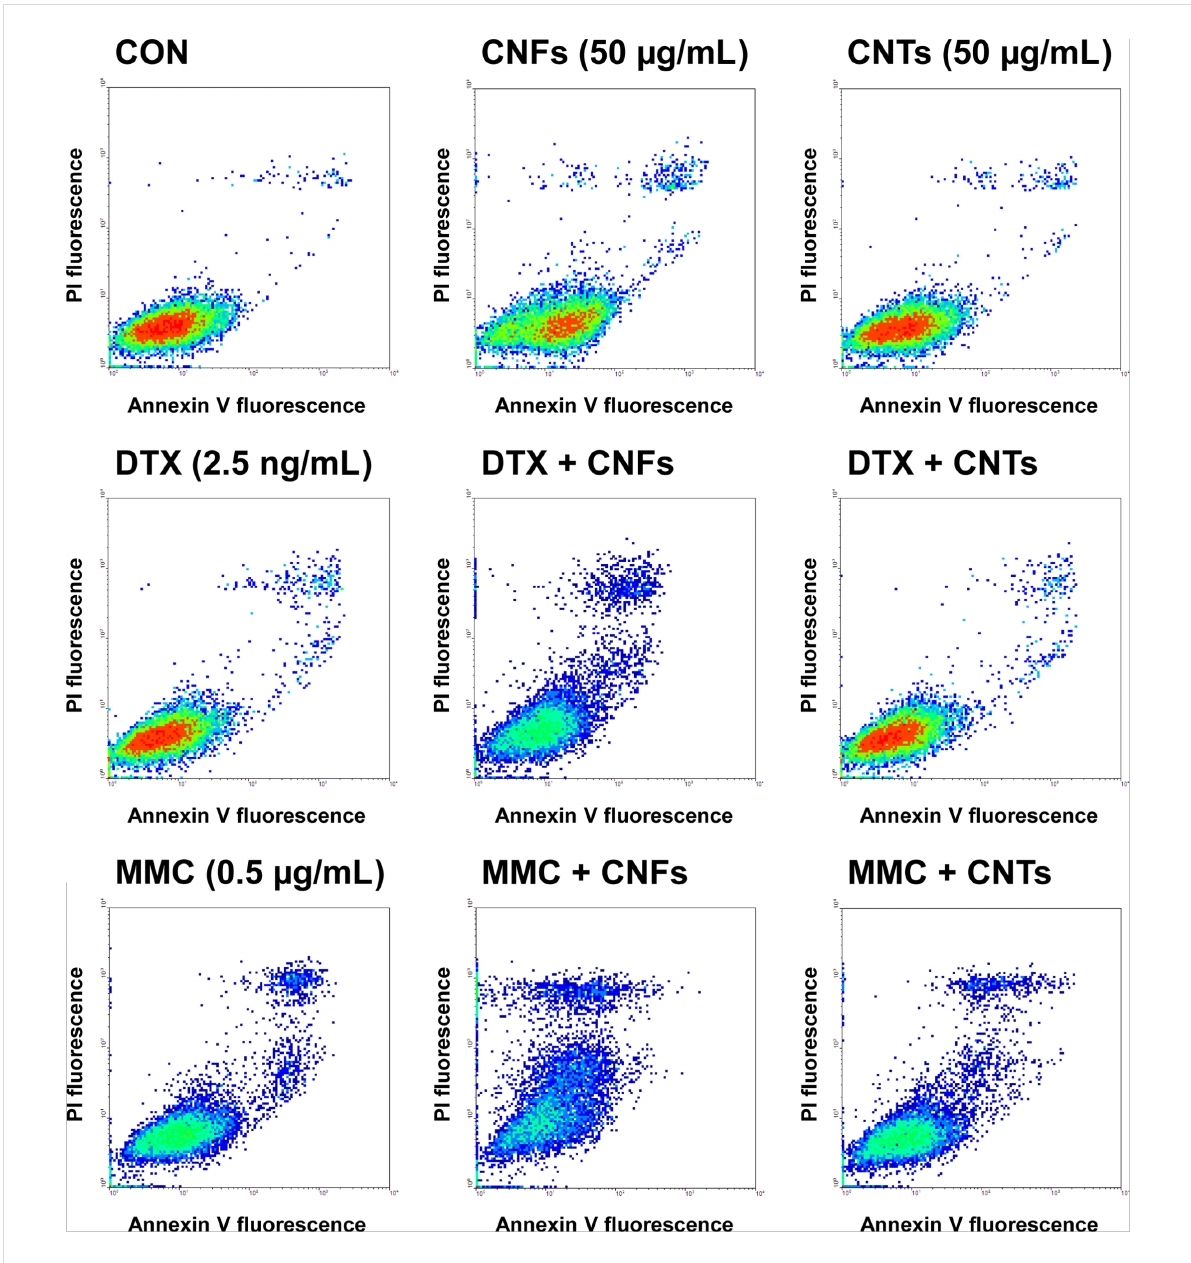
Figure 4: Exemplary flow cytometry analysis for cell death of DU-145 cells following treatment with carbon nanomaterials and chemotherapeutics alone or in combination. Combinatory treatments contained the respective carbon nanomaterial and chemotherapeutic in the same concentrations as indicated for the individual treatments. Untreated cells (CON) served as control